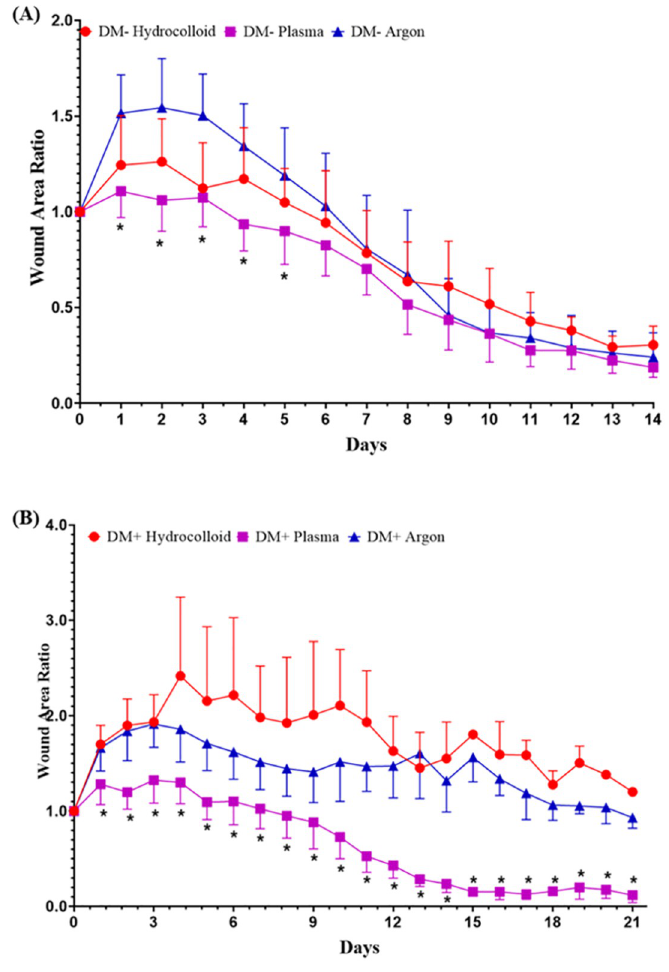
Fig 7. Comparison of wound area ratios in normal and diabetic mice. The ratios of wound areas to the initial area on day 0 are shown as line graphs for each day. (A) The wound area ratio in the DM- group is presented as the mean ± SD of ten wounds, and (B) the wound area ratio in the DM+ group as the mean ± SD of eight wounds. Values are expressed as the mean ± SD, ANOVA, Tukey-Kramer � p < 0.01.